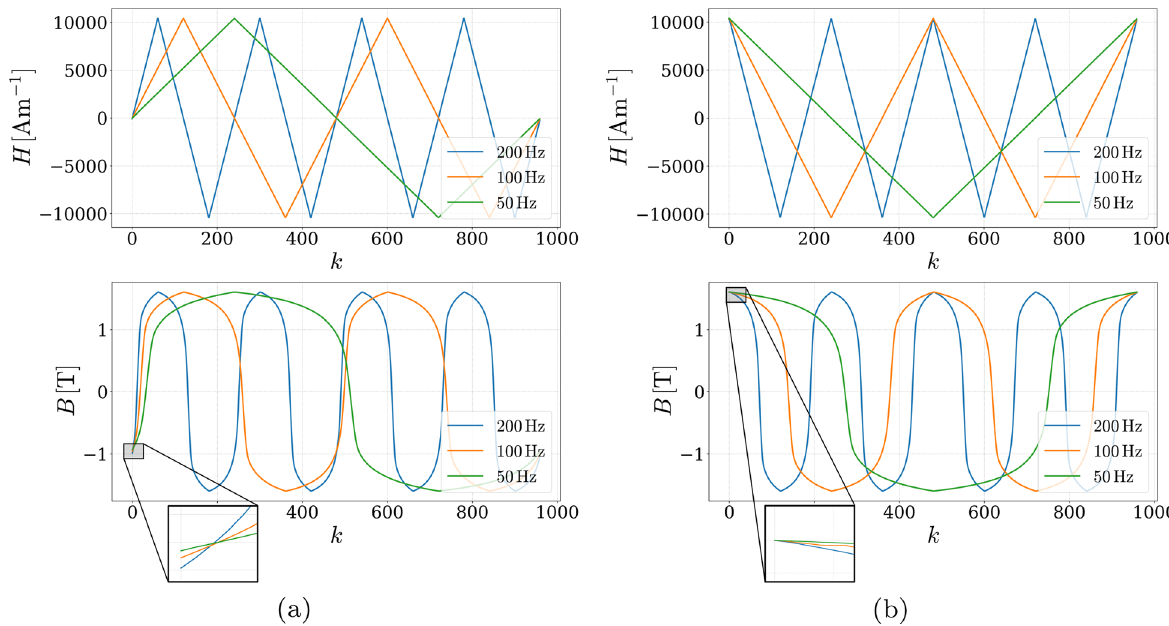
Fig. 8 a Exemplificative H and B curves contained in the measurement dataset before time shift. b The corresponding H and B curves after circular time shift. The curves are starting from positive saturation